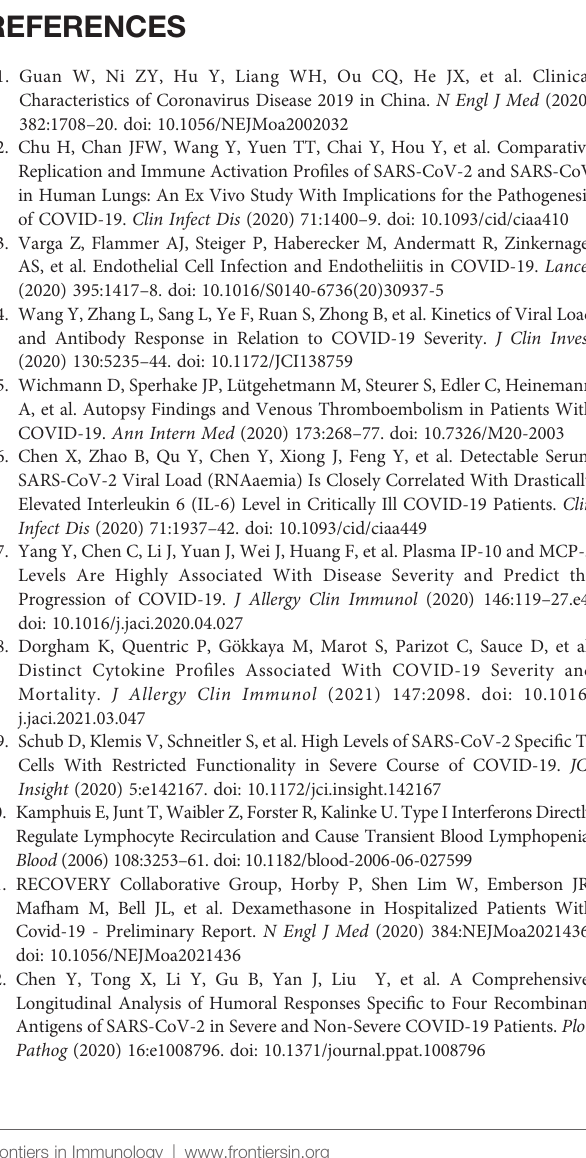
Supplementary Figure 3 | Lymphocyte percentages in BAL elements from severe COVID-19 patients. Survivors are closed symbols, non survivors are open symbols. First wave and second wave patients are represented (A) . BAL lymphocyte phenotyping in a representative patient from the fi rst wave. T cell lymphocytes are analyzed on CD45+ cells of total BAL cells No B cells or NK cells were detected (B) . Supplementary Figure 4 | Repartition of the peripheral effector and effector- memory T cell responses to SARS-CoV-2 measured in ELISpot-IFN g assay and tested against 18-mer peptides covering the nucleocapsid (NC) and spike (S) proteins, expressed as the percentage of the total response. NC peptides were divided in 4 pools and S peptides in 2 pools. NC peptides were tested in one superpool in one patient. Results are expressed as percentages of the magnitude (SFC/10 6 PBMC) of the total SARS-CoV-2 cellular speci fi c response. Patients groups are divided in fi rst wave/second wave patients and in survivors/non survivors. Supplementary Table 4 | SARS-CoV-2-speci fi c ELISpot assay in non-exposed donors (SFC/106 ^ 6PBMC). Supplementary Table 5 | Antibodies used for mass imaging